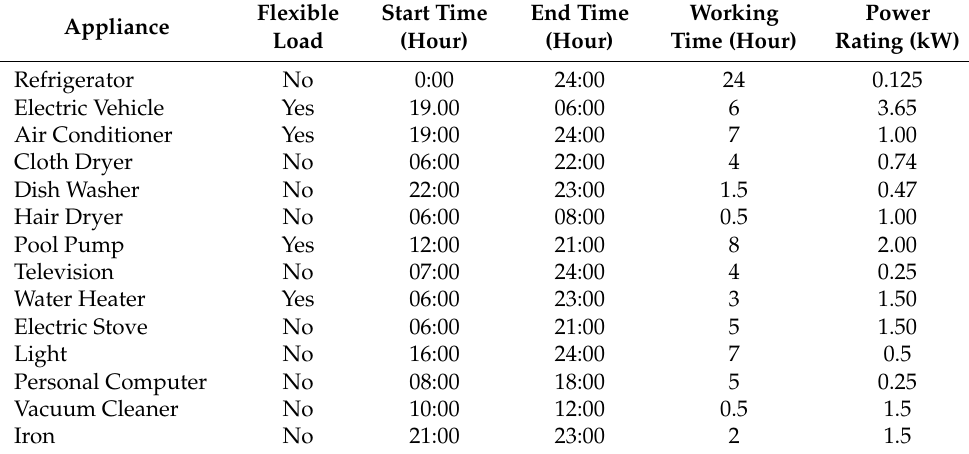
Table 8. Example of appliances operational time specification.